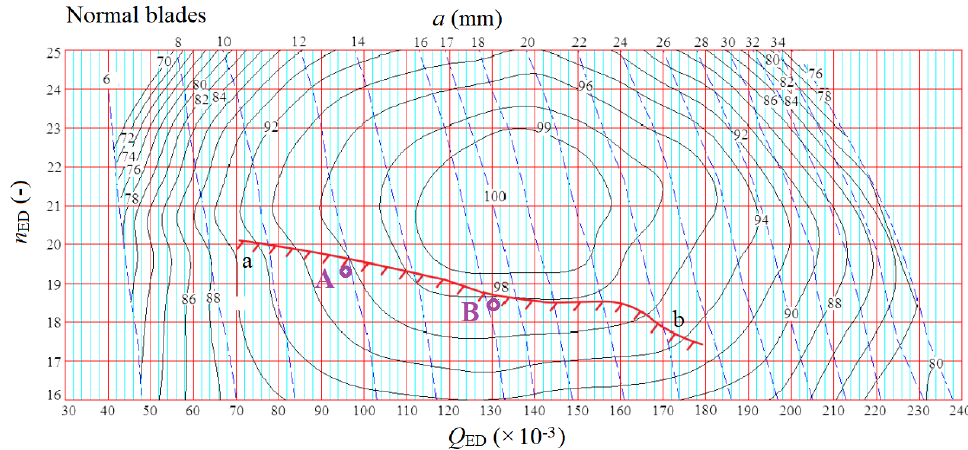
Figure 8. Hill diagram in parameters ( Q ED , discharge factor; n ED , speed factor) for the normal blades.